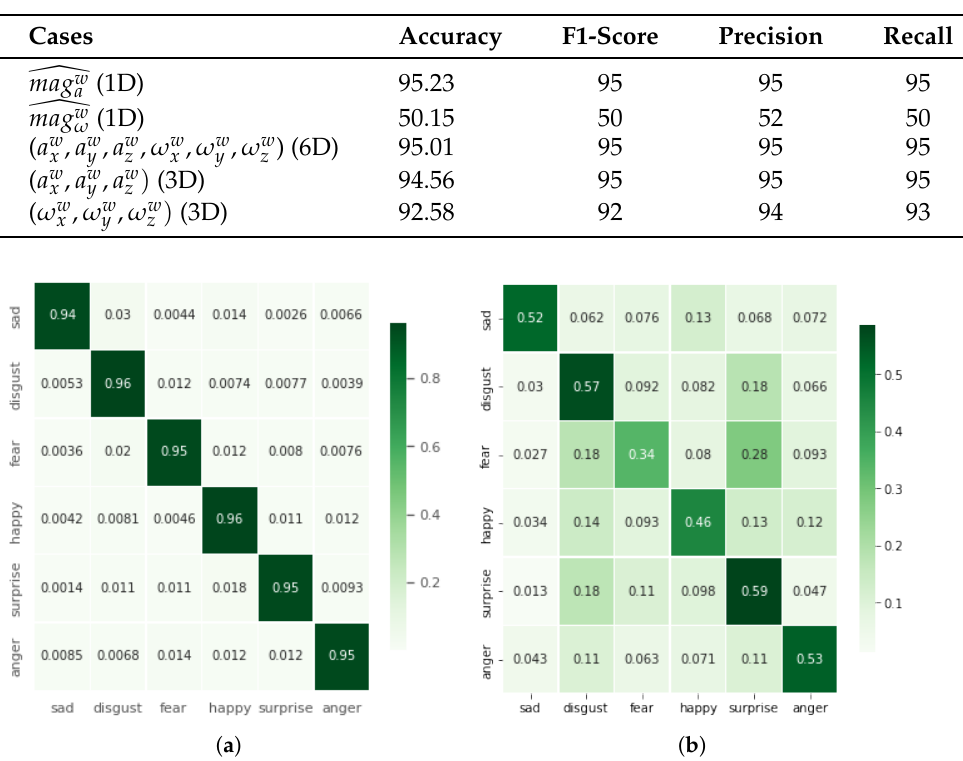
Figure 4. ( a ) Confusion matrices computed from the magnitude of 3D accelerations; ( b ) confusion matrices computed from the magnitude of 3D angular